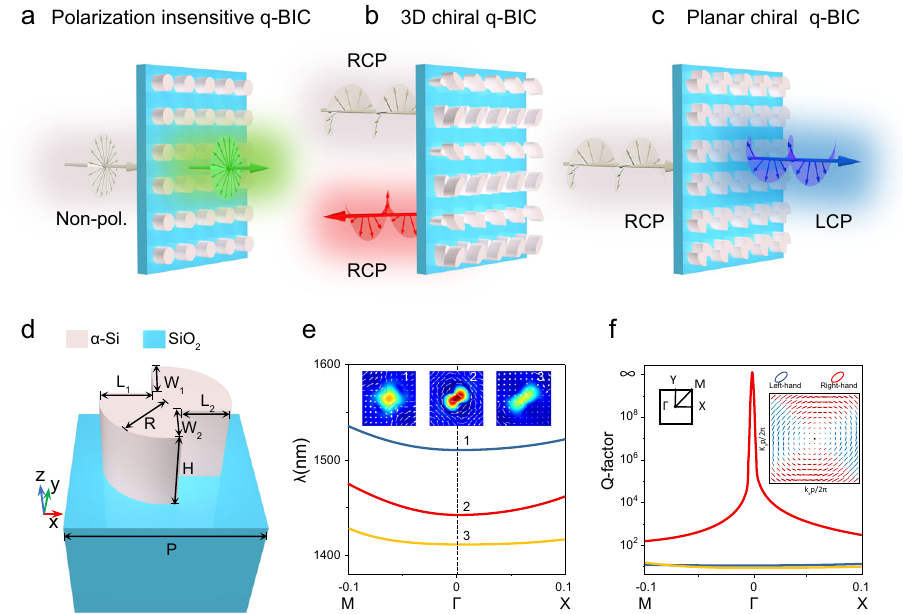
Fig. 1 Schematics of different BIC states and planar chiral q-BIC metasurface with a polarization singularity enclosed by vortex elliptical eigen- polarizations with non-vanishing helicities. a – c Comparison of q-BICs ( a ) in planar metasurfaces without polarization effect, ( b ) in stereo-nanostructures with 3D chiral effect in re fl ection, and ( c ) in planar metasurfaces with 2D chiral effect in transmission. d Schematic of the unit cell of the planar chiral q-BIC metasurface formed by the amorphous silicon ( α -Si) DSS structure on a SiO 2 substrate with parameters P = 850 nm, R = 280 nm, L 1 = L 2 = 220nm, W 1 = W 2 = 191 nm, and H = 350 nm. e Simulated band structure with real parts of the eigen-wavelength of the DSS metasurface near the Г point. Insets show the fi eld patterns (color: magnetic distributions, arrow: electric vectors) of the three typical modes. f Simulated Q-factors of the eigenmode in the k - space in the vicinity of the Г point. Insets show the fi rst Brillouin zone and eigen-polarization pro fi les. On the eigen-polarization pro fi le, the polarization states are represented by ellipses of which the blue and red represent the eigen left-handed and right-handed states, respectively, and the black dot represents the V point